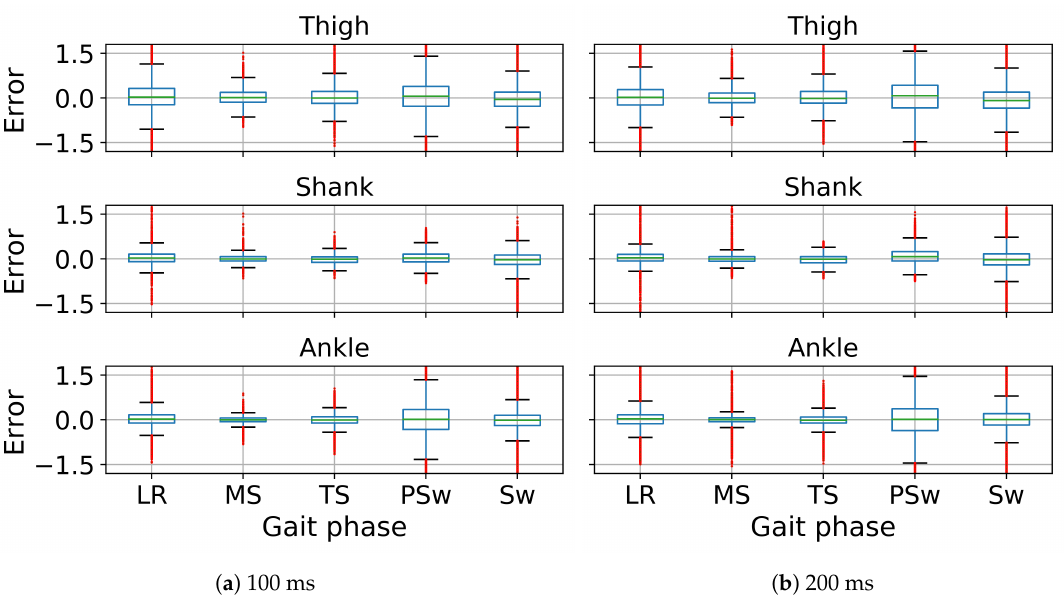
Figure 11. Error of angular velocities of ipsilateral thigh, shank and foot in 100 ms ( a ) and 200 ms ( b ) ahead prediction with respect to gait phases in inter-subject implementation. All angular velocity values shown are normalized to have zero mean and unit variance. The line inside the box represents the median error. The box represents the middle 50% of the error. The whiskers represent the ranges for the bottom 25% and the top 25% of the error, excluding outliers. The red tails indicate the